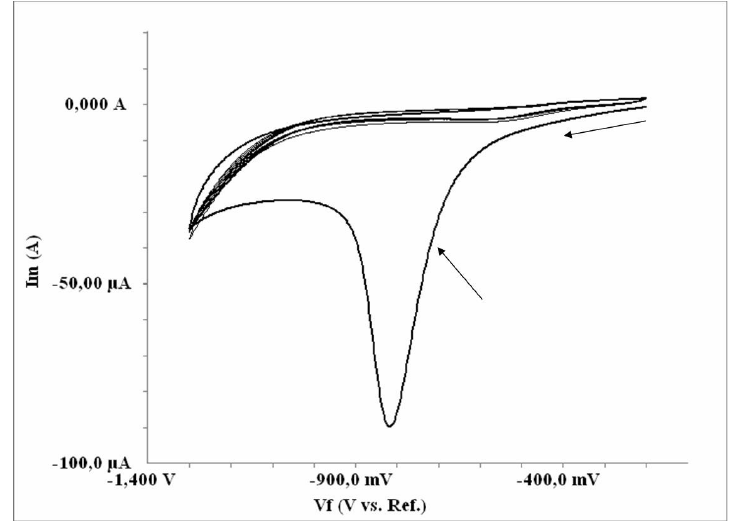
Figure 6. Reduction of nitro group voltammograms to amine on nitrophenyl modified glassy carbon electrode